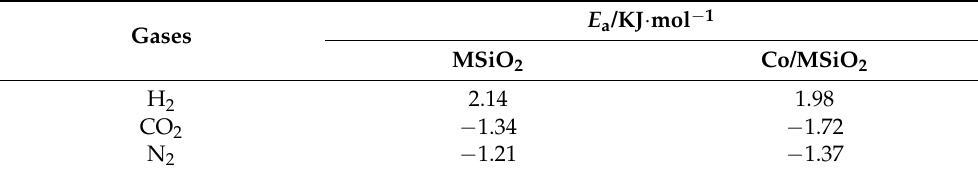
Table 2. E a values of gases (H 2 , CO 2 , and N 2 ) calculated from Arrhenius formula for supported